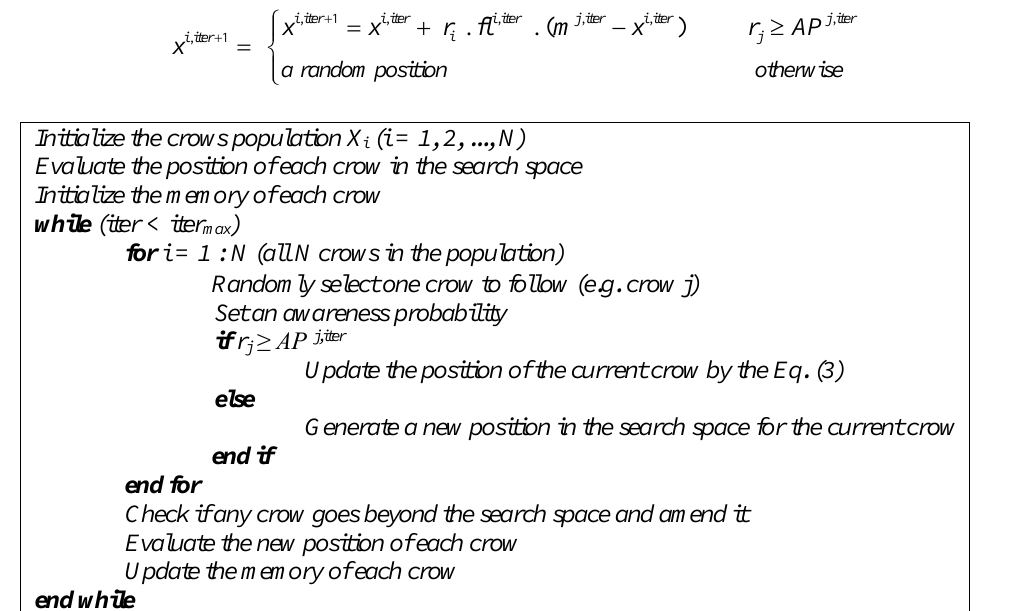
Figure 2. Pseudocode of the